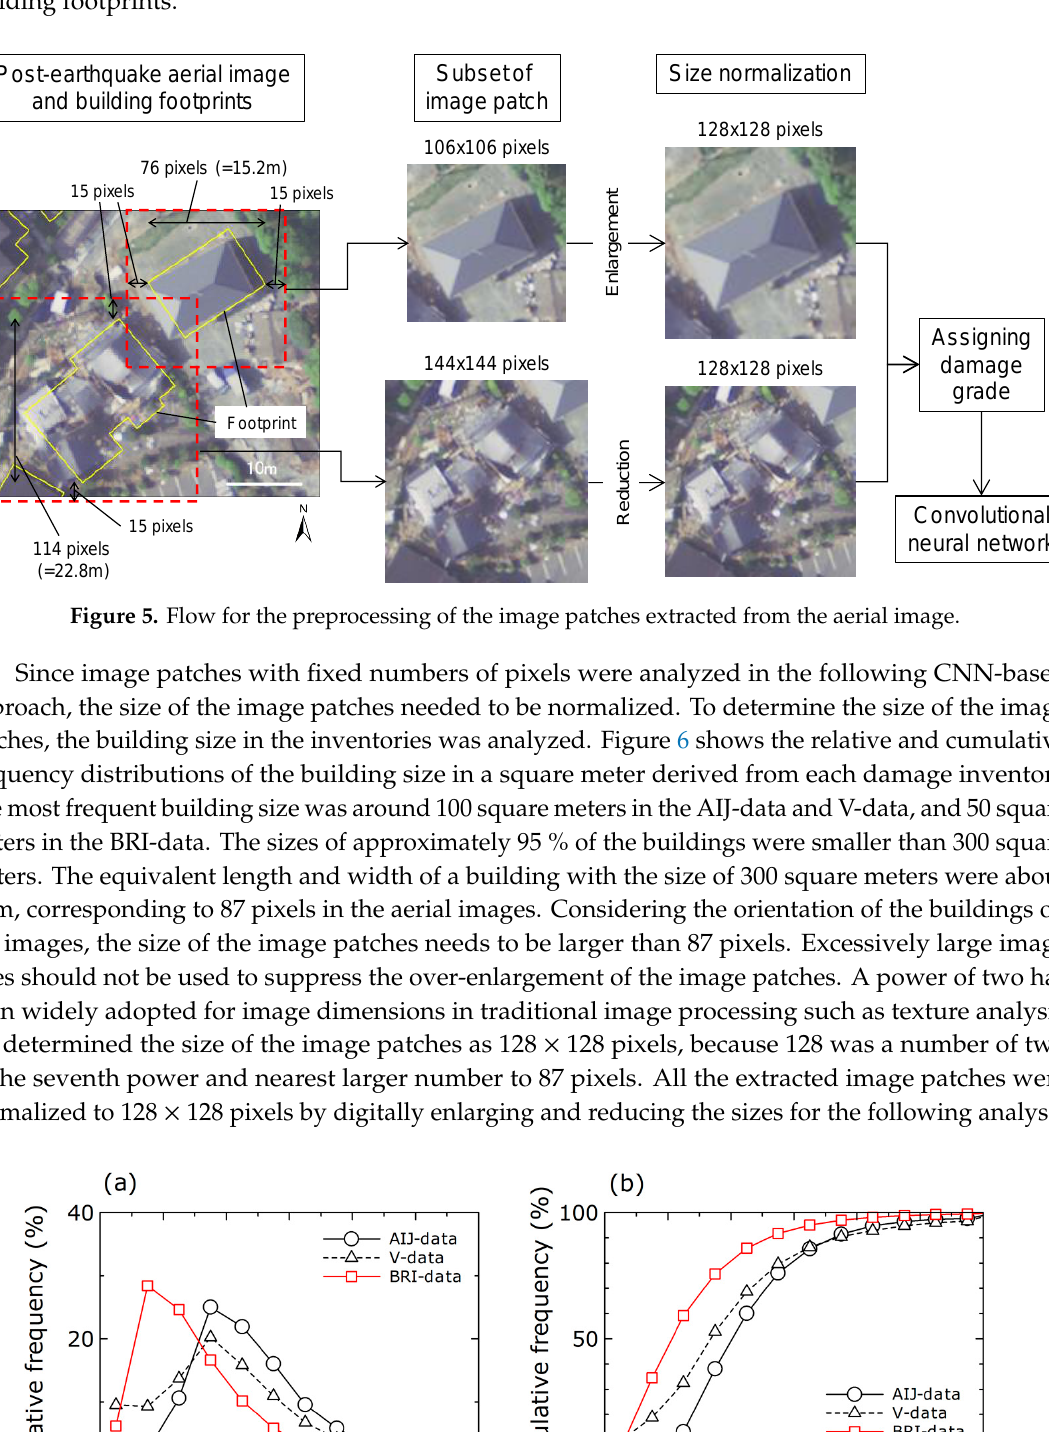
Figure 6. ( a ) Relative frequencies of the building size. ( b ) Cumulative frequencies of the building